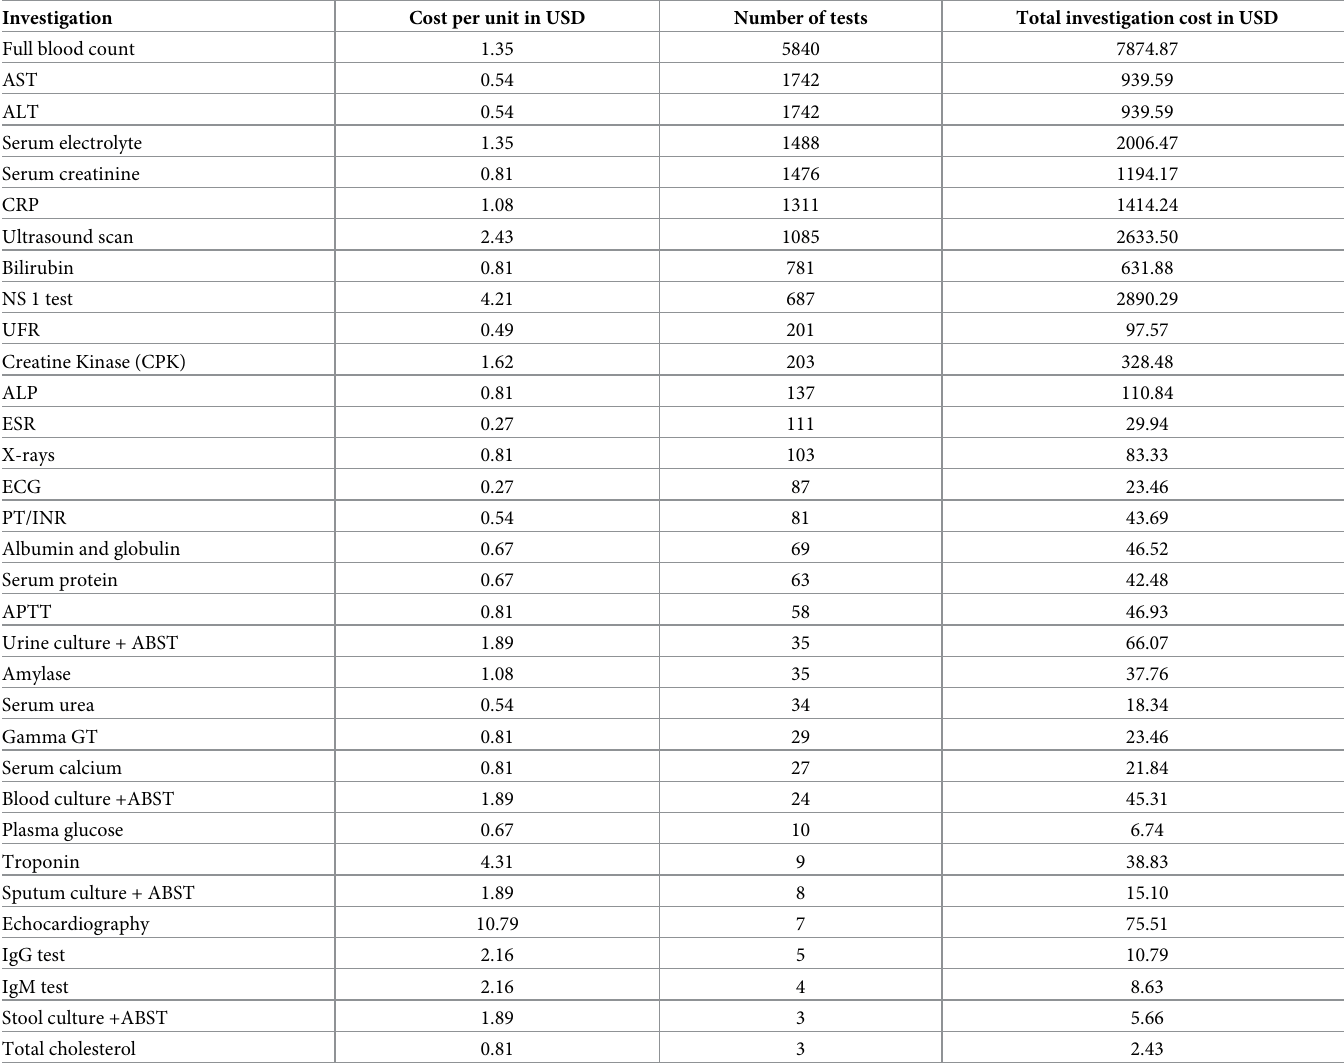
Table 4. Investigation numbers and associated costs during the 29-month assessment